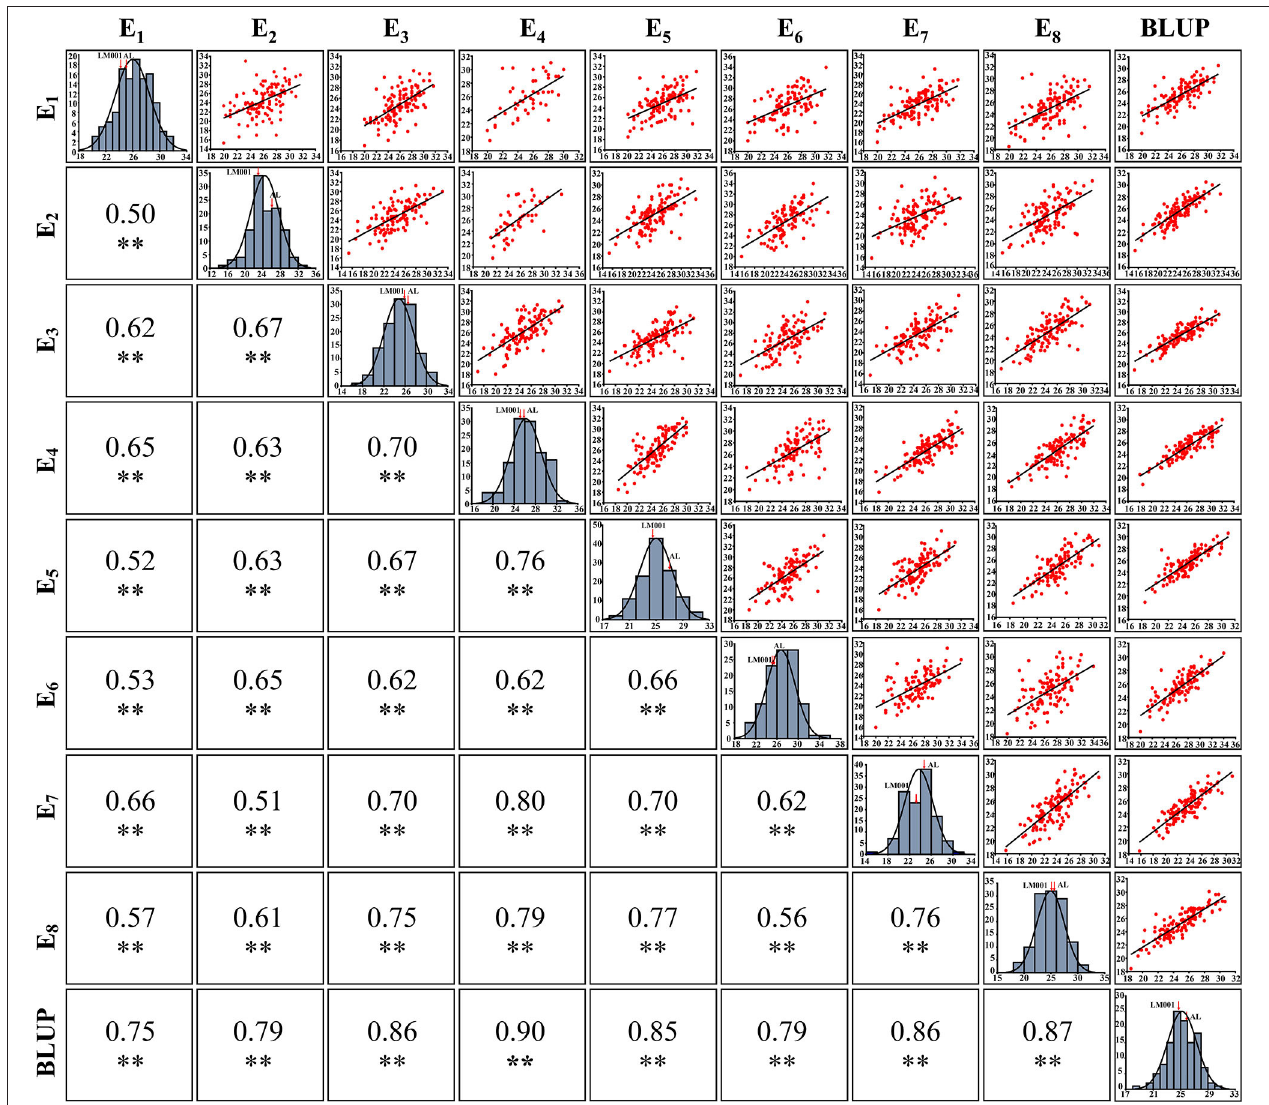
FIGURE 3 | The phenotype, frequency distribution, and correlation coefficients of spikelet number per spike (SNS) in multiple environments. **Significance level at p < 0.01.